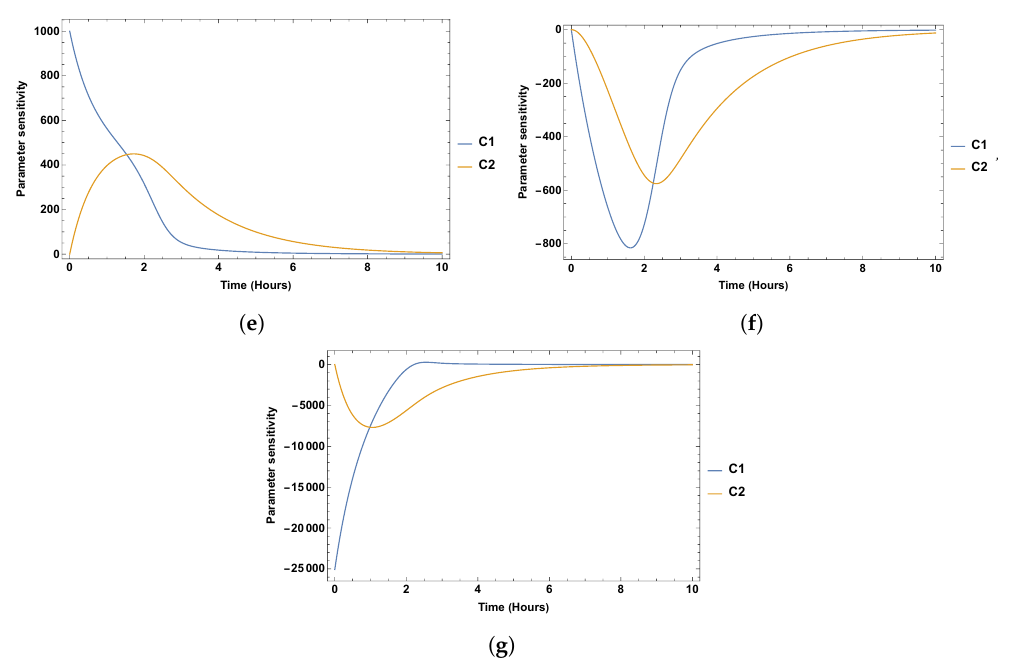
Figure 4. IV bolus sensitivity analysis. ( a ) Transfer rate, k 12 . ( b ) Degradation rate, k 21 . ( c ) Michaelis– Menten constant, K m . ( d ) Fractional order, α . ( e ) Dose, D . ( f ) Maximum rate of elimination, V m . ( g ) Central Volume of distribution, V 1 .